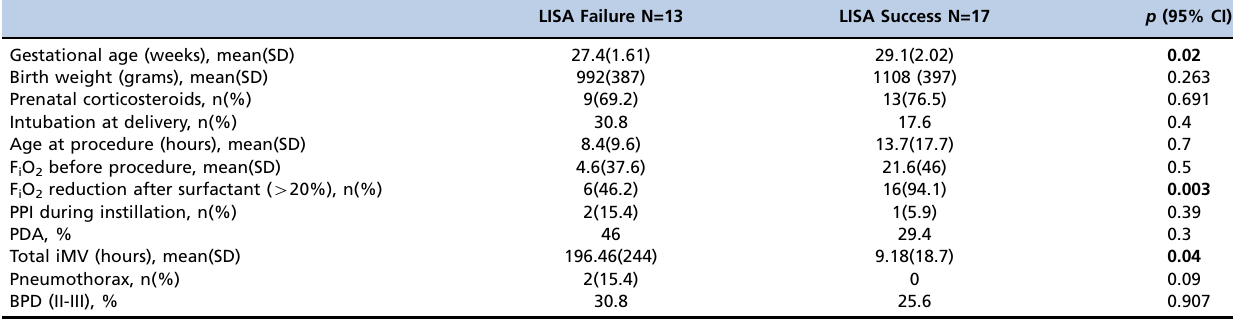
Table 4 - Comparison of variables between the less invasive surfactant administration success and failure groups. LISA Failure N=13 LISA Success N=17 p (95% CI) Gestational age (weeks),